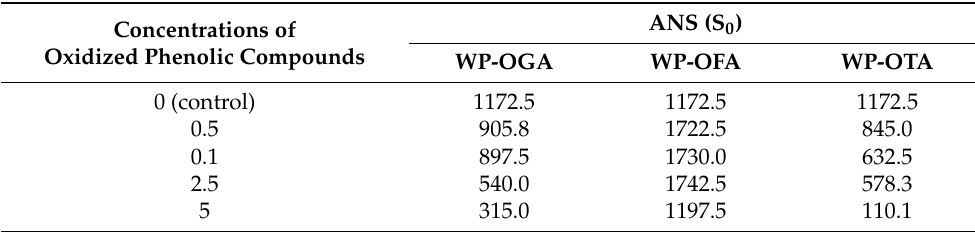
Table 1. Surface hydrophobicity of whey protein modified with different oxidized phenolic com- pounds at various